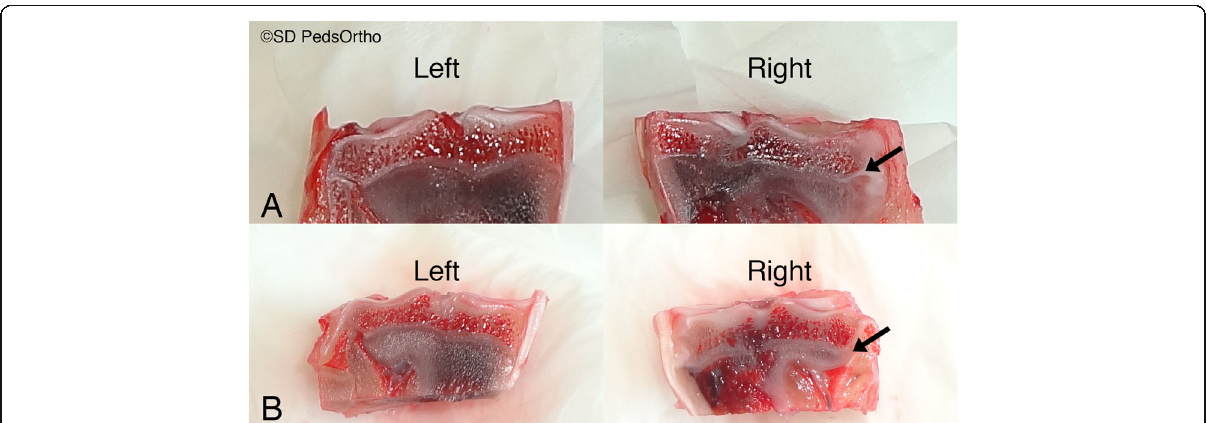
Fig. 4 OilRedO stained mid-coronal proximal tibia section. Note, bright red stain in bone marrow indicating fat. a Fat Group, b Periosteum Group examples: arrow shows fracture and fat graft or periosteum placement location (no red stain after 6 weeks of